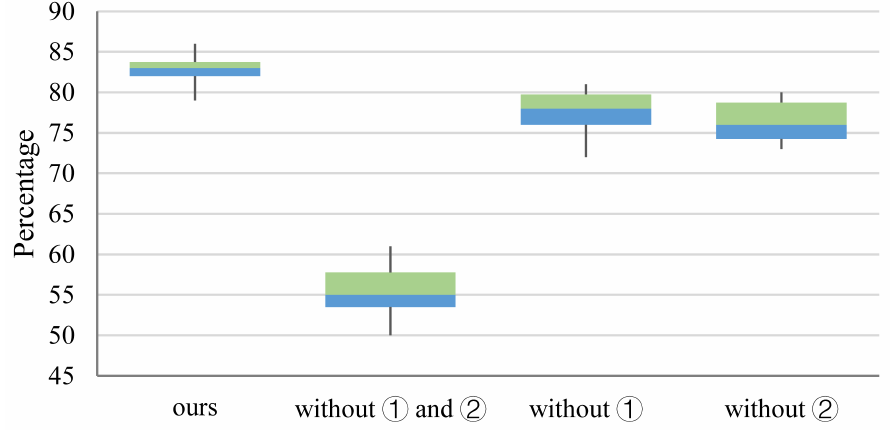
Figure 5. Statistical distribution of the probability of no impact on testing models’